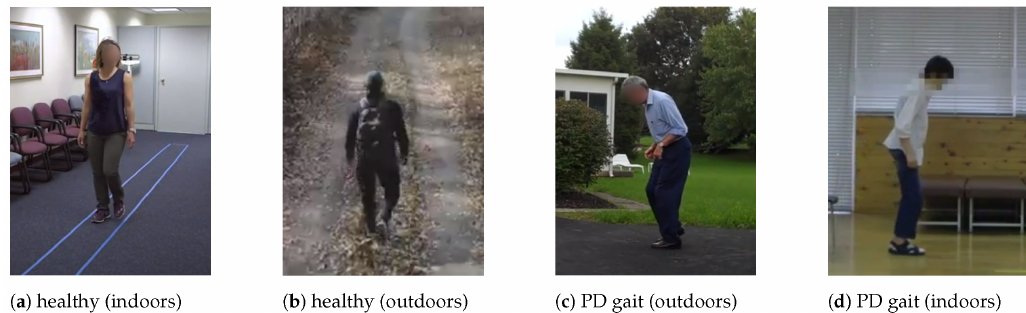
Figure 2. Examples of subjects in the dataset with healthy gait and PD in outdoor and indoor environments.